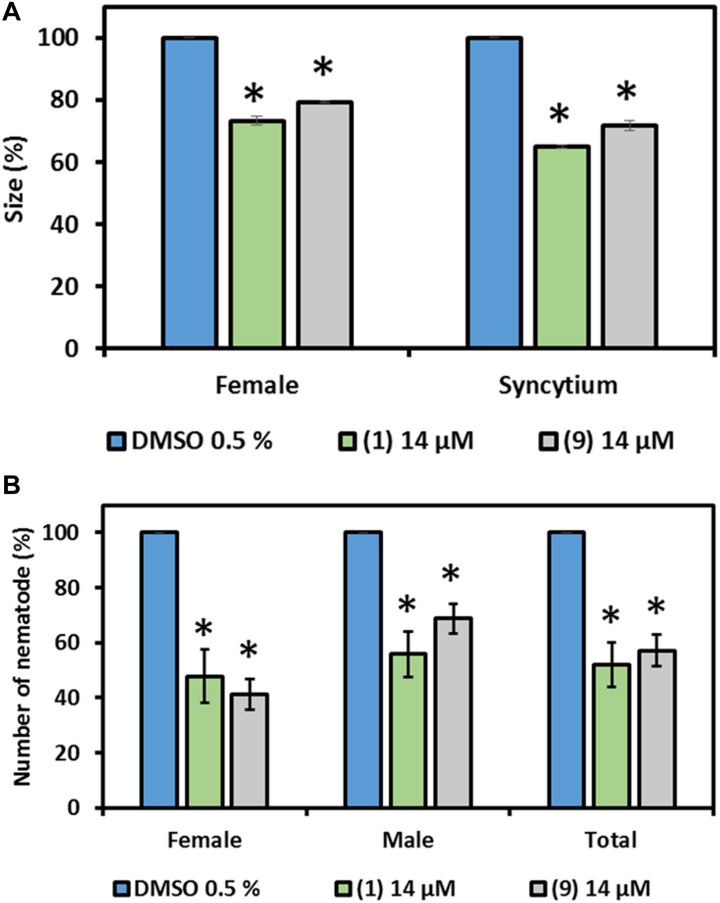
Effect of prodigiosin (1) and derivative 9 on H. schachtii parasitism of A. thaliana. Plants were grown on Knoṕs agar mixed with prodigiosin (1) and derivative 9 and were infected with J2s of H. schachtii. Susceptibility parameters were (A) average percentage of females, males and total nematodes per plant compared with control and (B) average percentage of sizes of females and syncytia at 13 DAI. Plants grown on medium mixed with DMSO (0.5% final concentration) were used as control. Data are based on three independent experiments. Each bar represents the mean ± standard error of n > 35. Asterisks indicate significant differences to the control based on one-way ANOVA followed by Dunnett’s post-hoc test (P < 0.05).